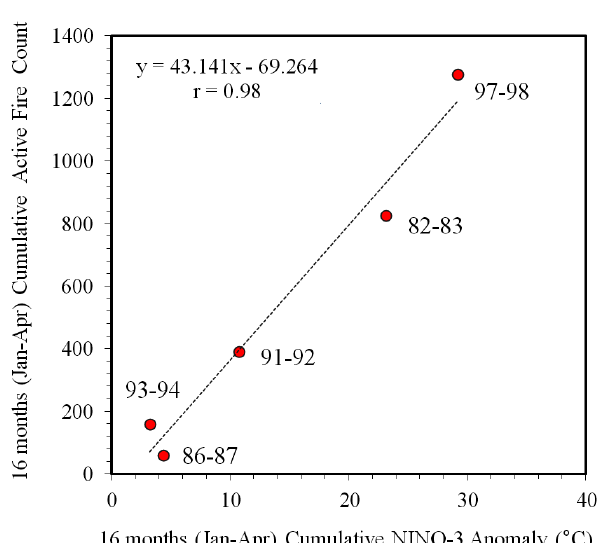
Fig. 10. Relationship between Borneo’s cumulative active fire count derived from AVHRR GAC imagery (calculated from the monthly data shown in Fig. 9) and cumulative El Ni˜no strength, here calcu- lated from the integration of the NINO3 anomaly index over the 16 months of each El Ni˜no encompassing the first and second fire sub- seasons defined in Sect. 5.2 (i.e. Jan ENSO Year 1 to Apr ENSO Year 2). The linear best fit to the data is shown, and the alterna- tive relationships calculated for other durations and using alterna- tive ENSO indices are shown in Table